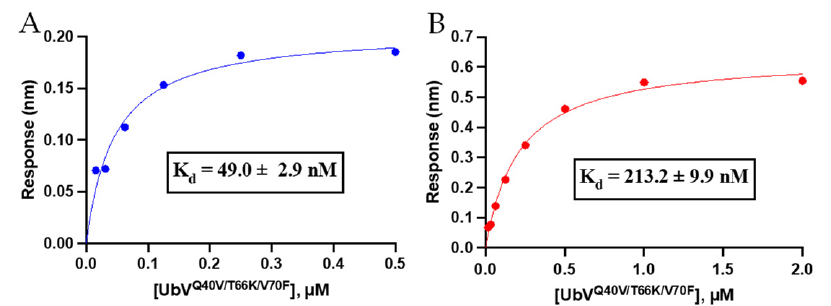
Figure 3. Steady-state binding curves for UbV Q40V/T66K/V70F for determination K d using BLI for UCHL3 ( A , blue) and UCHL1 ( B , red). Corresponding association/dissociation curves for each replicate are provided in the supplementary materials Figure S2.